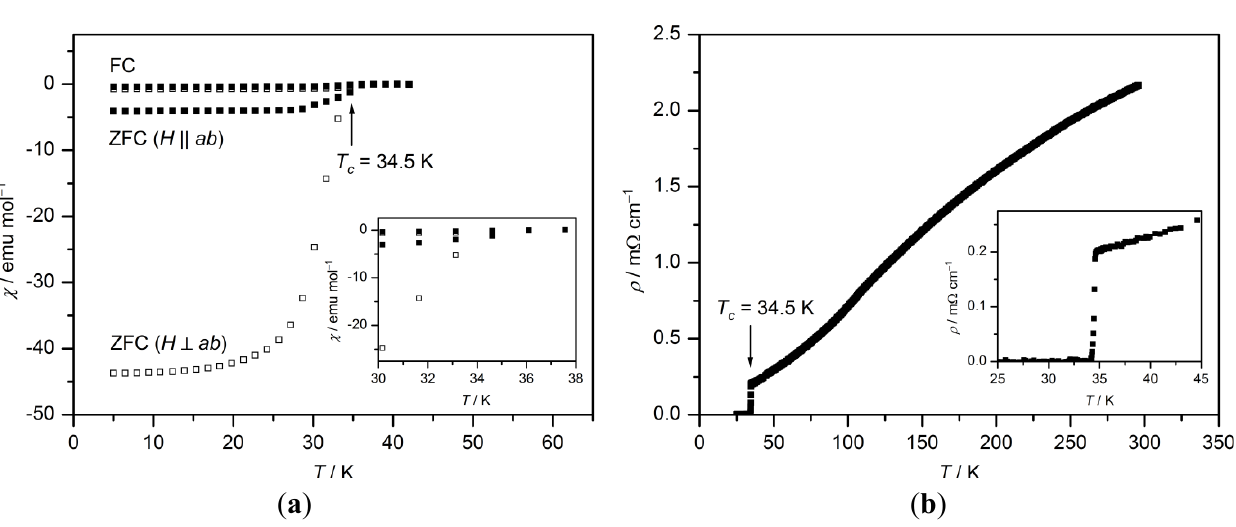
Figure 7. Temperature dependence of the zero-field cooled (ZFC) and field cooled (FC) DC magnetic susceptibility ( μ H = 100 Oe) ( a ) and DC resistivity ( b ) of an oriented single 0 crystal of Ca Na FFeAs. (The insets are showing close-ups of the transition regions.) 0.89 0.11